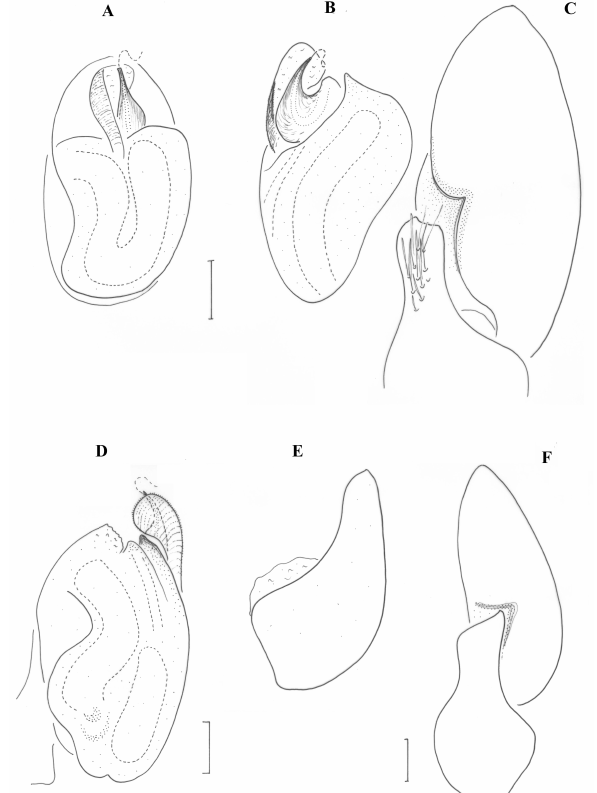
Figure 13. Phaeocedus similaris n.sp., male pedipalp (holotype). ( A ) Ventral view, ( B ) Tegulum, retrolateral view, ( C ) Tibial apophysis, retrolateral to dorsal view, ( D ) Tegulum, prolateral view, ( E ) Tibial apophysis, retrolateral to ventral view, ( F ) Tibial apophysis, retrolateral